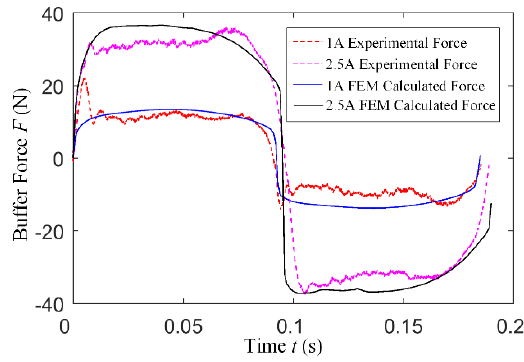
ff er force curve at 5 Hz Figure 19. Buffer force curve at 5 Hz frequency. Figure 19. Bu